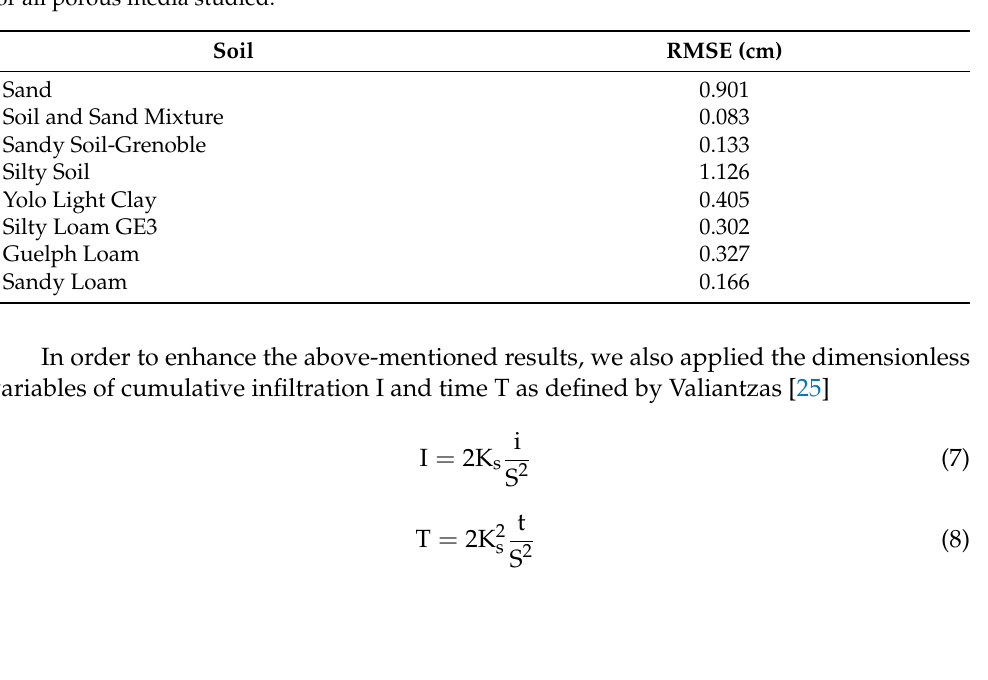
Table 2. Root mean square error values (RMSE) of the predicted relationships i(t) from Equation (6) for all porous media